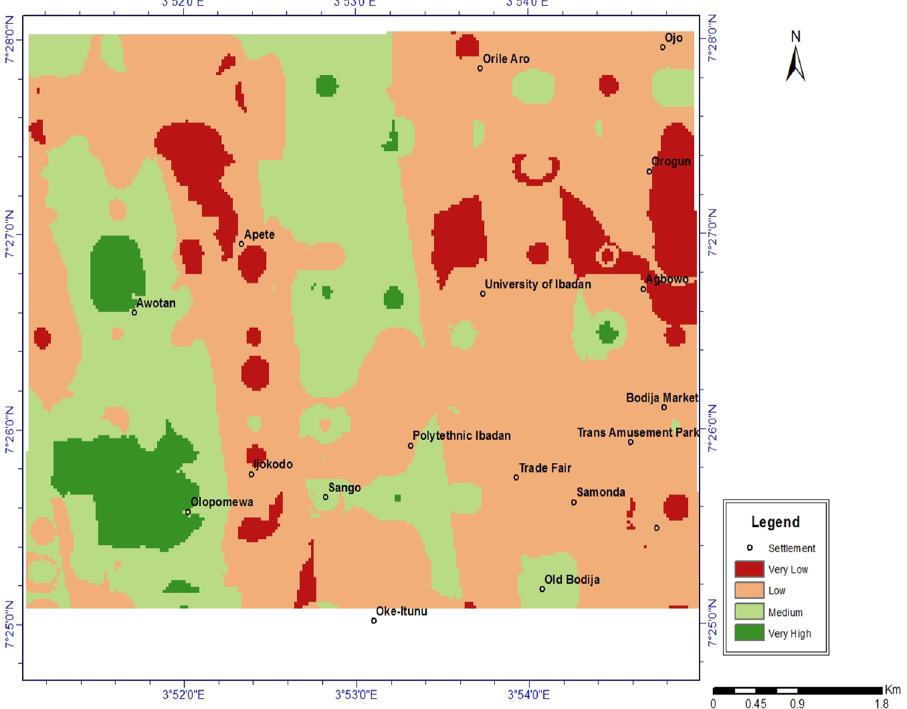
Fig. 14 Groundwater potential map of the study